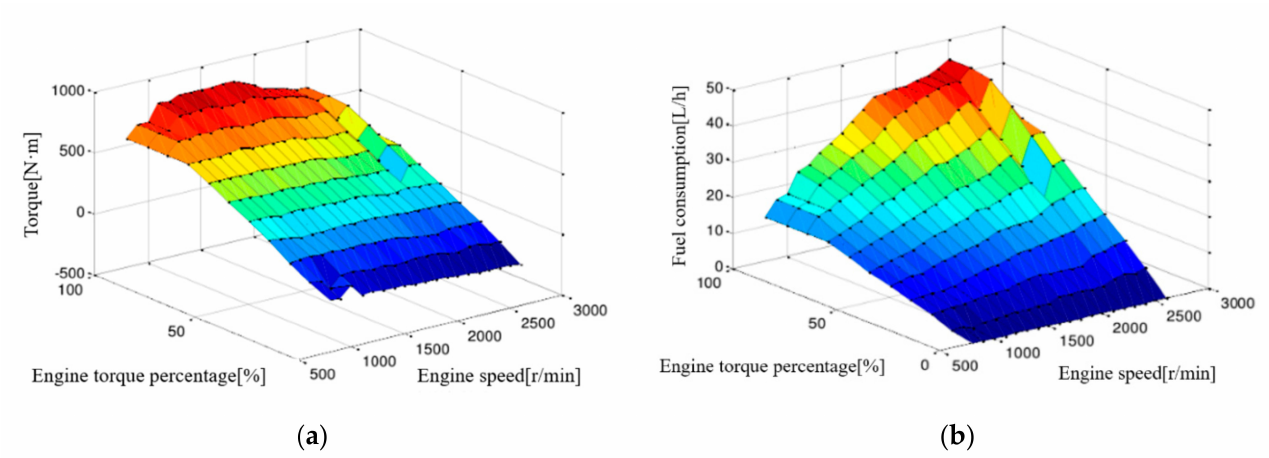
Figure 3. Engine torque and fuel consumption map. ( a ) Engine torque map. ( b ) Engine fuel consumption